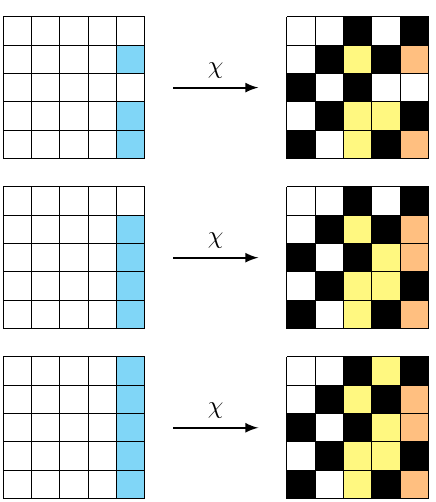
Figure 10: Linear equations derived when the outer state is two planes. The blue bits in blue are fixed. We satisfy constancy on the yellow bits by finding solutions to L . The orange bits are equal to the blue bits with high